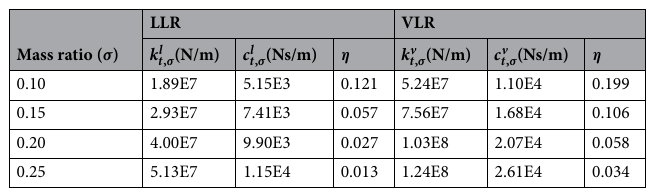
Table 2. Optimal TMD parameters for different mass ratios to control lateral and vertical flexural